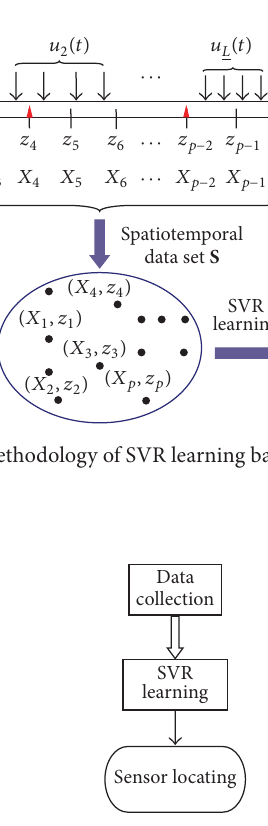
Figure 5: Systematic design for sensor placement.